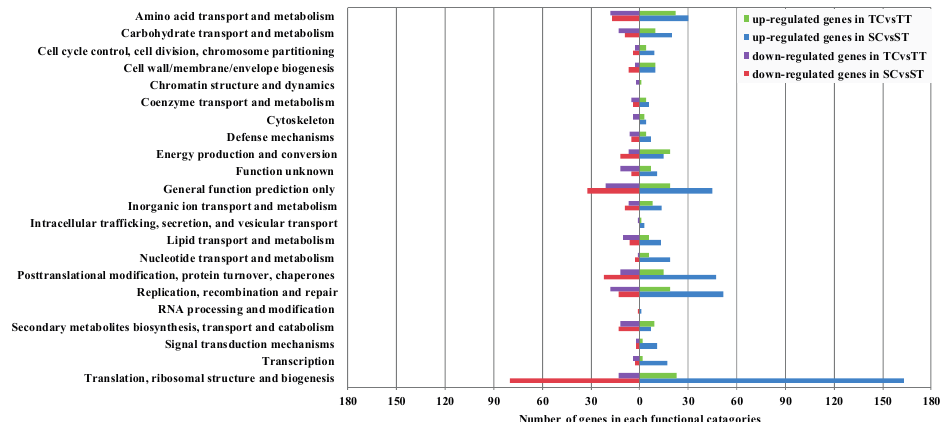
Figure 4. Functional classification of differentially expressed genes in the tolerant and susceptible maize. Identified differentially expressed genes (DEGs) were classified into functional categories and the number of up- or down-regulated functional categories were shown here. Transcripts without any annotation information from BLASTx program were collected into “Function unknown”.